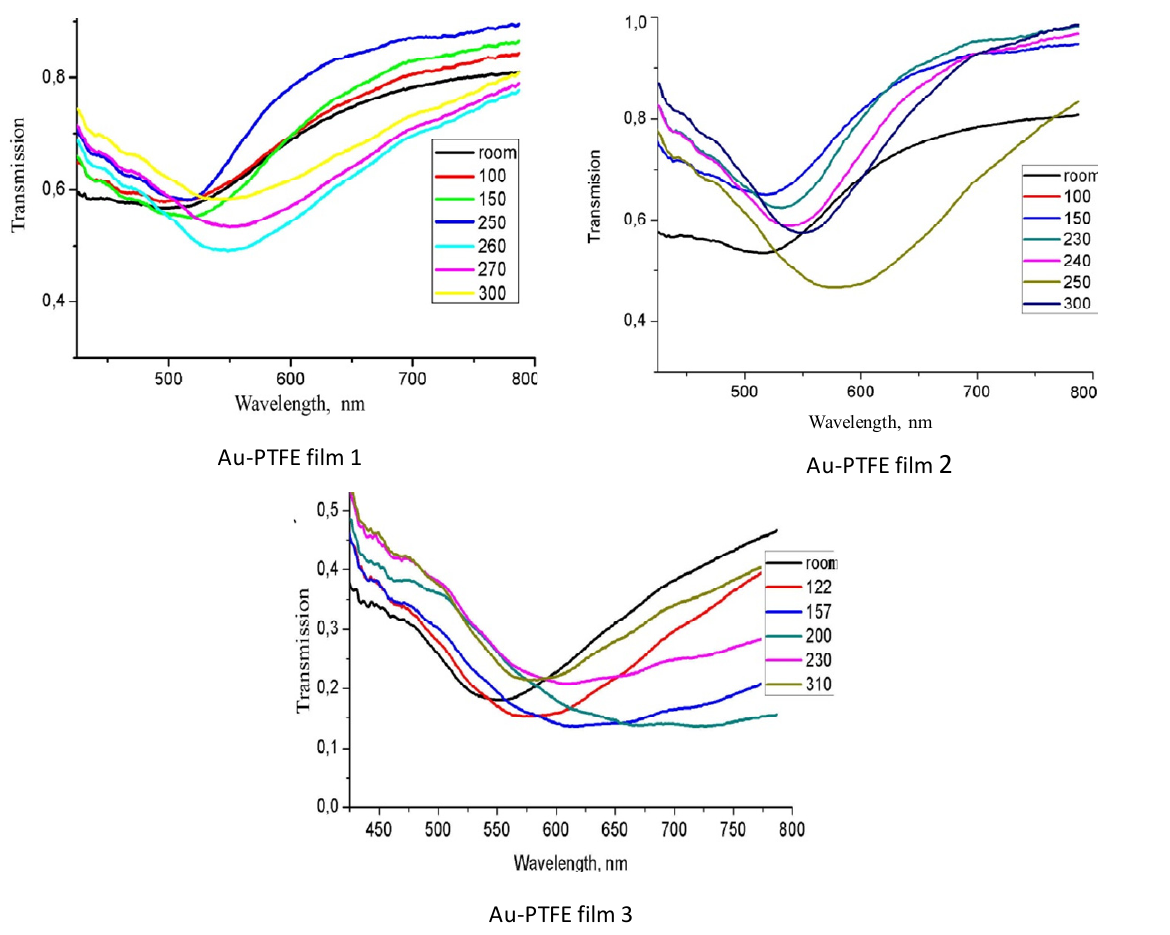
Figure 3. Optical transmission spectra of the Au + PTFE films recorded during the annealing. Au concentration is increased from 1 to 3 (from about 5 to 21 vol